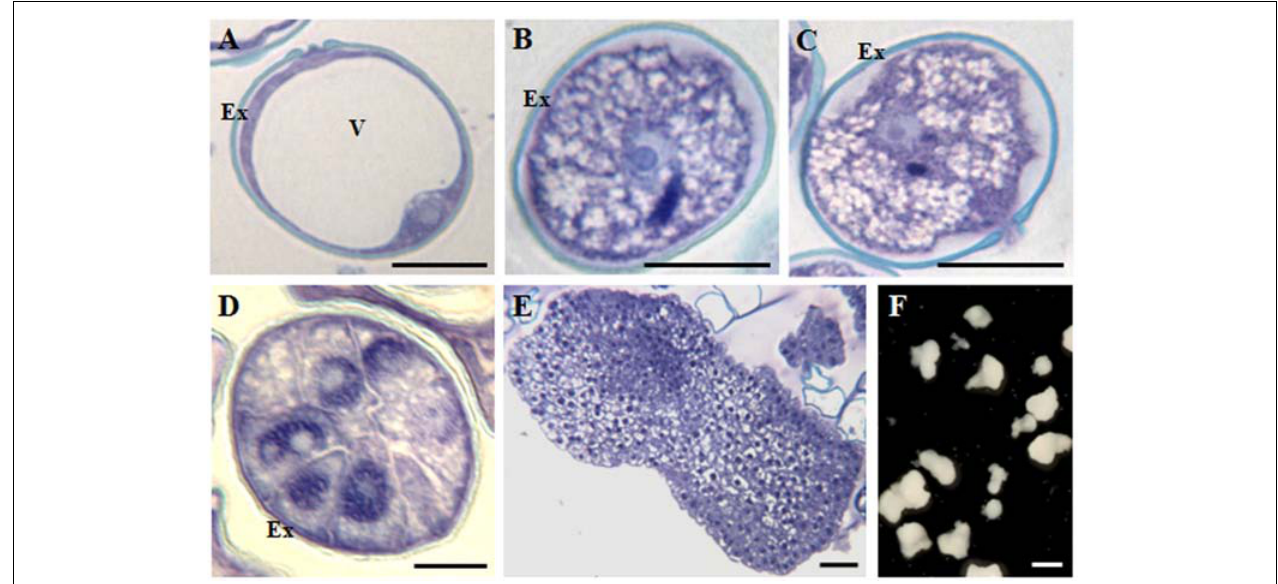
FIGURE 2 | Main stages of pollen development and microspore embryogenesis of Hordeum vulgare . Micrographs of semithin sections stained by Toluidine blue showing the cellular organization. (A) Vacuolated microspore. (B,C) Gametophytic development. (B) Bicellular pollne. (C) Tricellular pollen. (D–F) Microspore embryogenesis. (D) Proembryo. (E) Transitional embryo. (F) Coleoptilar embryos, with different degrees of development, panoramic view of a Petri dish of a microspore embryogenesis culture after 30 days. Ex, exine; V, vacuole. Bars represent: (A–C) : 10 µ m, (D) : 20 µ m, (E) : 100 µ m, (F) : 1 mm.